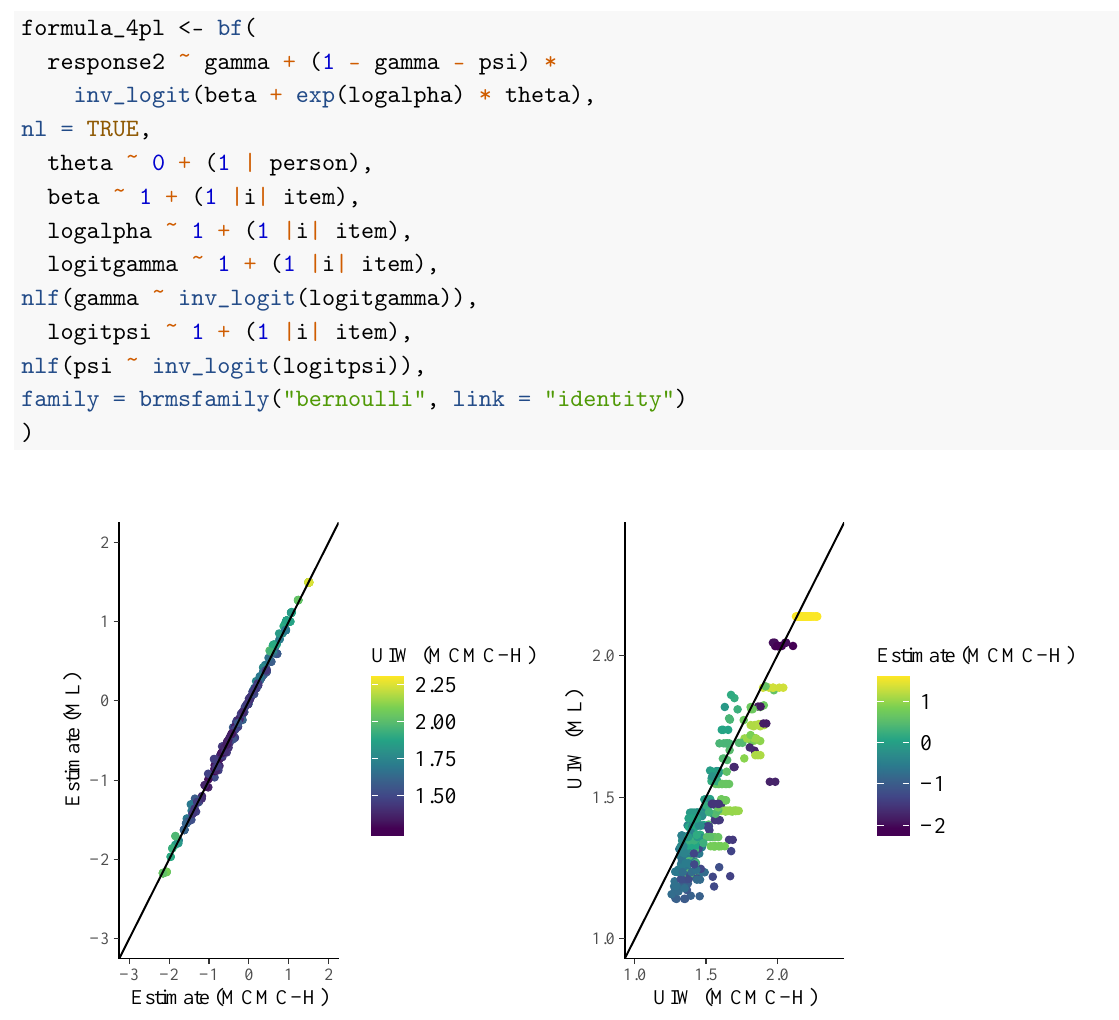
Figure 4. Comparison of 3PL person parameters: (Left) scatter plot of point estimates; and (Right) scatter plot of the associated 95% uncertainty interval widths